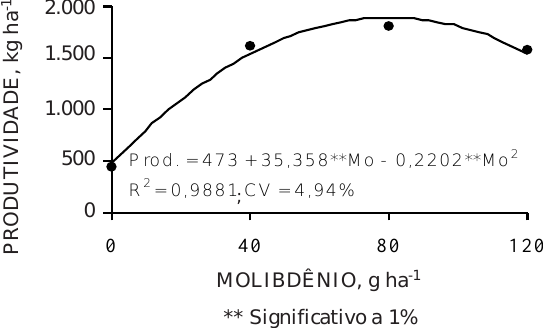
Figura 2. Teores de Mo, N total e N orgânico (N org) nas folhas e nos grãos do feijoeiro cv. Ouro Negro, cultivado na safra outono-inverno de 1996, em função da adubação foliar com